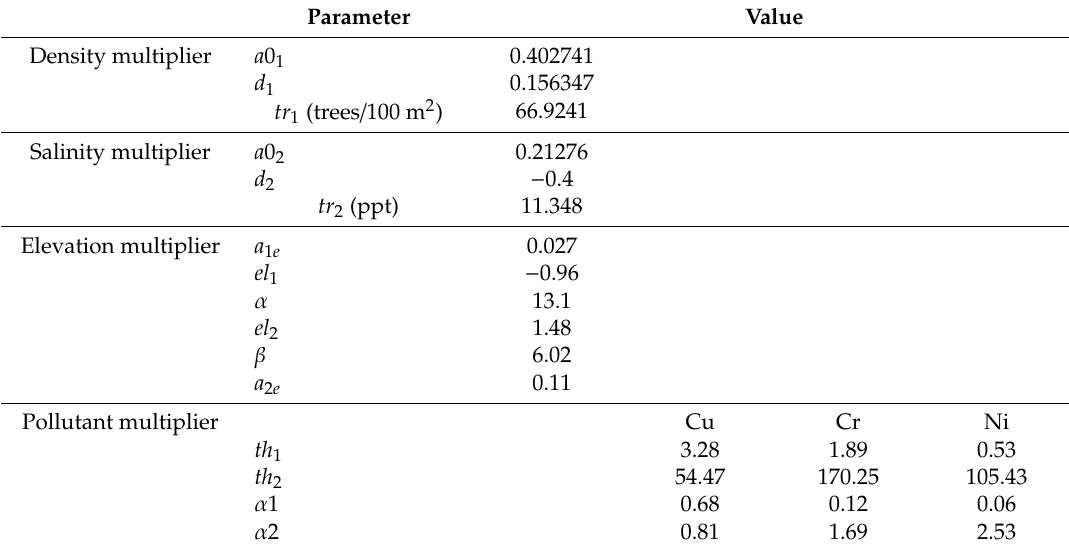
Table 4. Result of the parameter